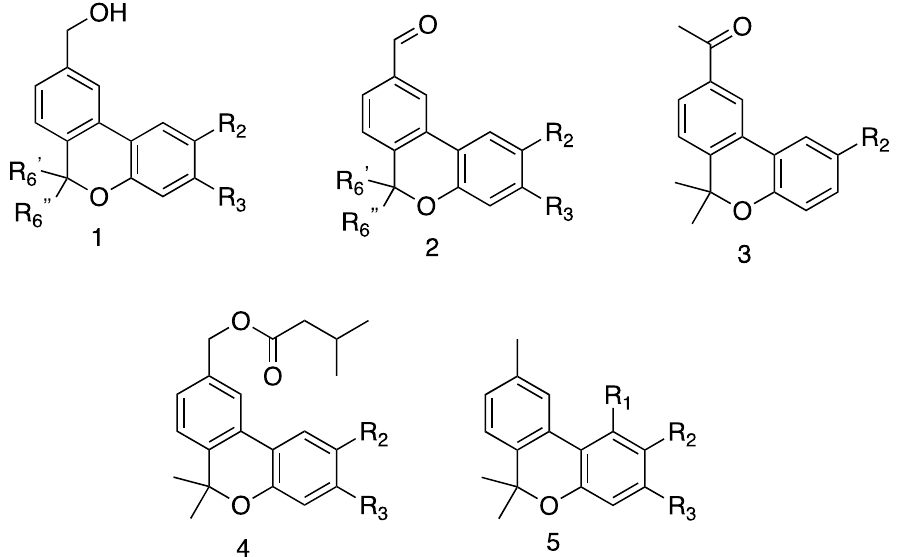
Figure 2. Prepared derivatives. 1a R 2 = OMe, R 3 = H, R 6 ′ = Me, R 6 ″ = Me; 1b R 2 = isopropyl, R 3 =